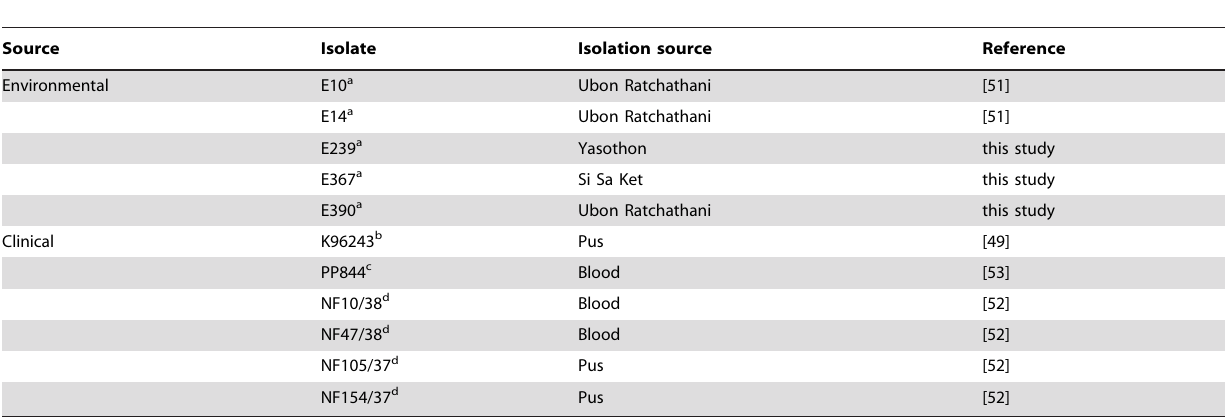
Table 3. All Burkholderia pseudomallei strains used in this